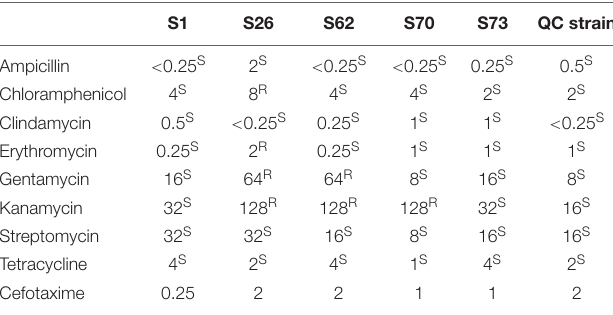
TABLE 6 | Susceptibility test of selected candidate strains to antibiotics.